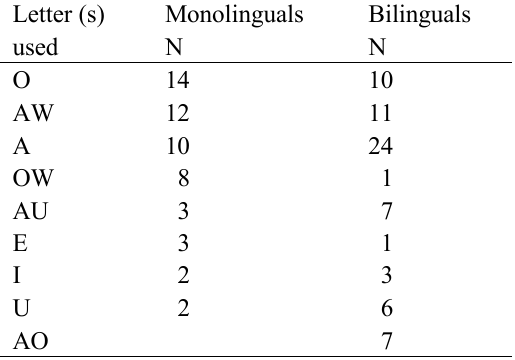
Table 8. Misspellings for the phoneme / aʊ / in trousers